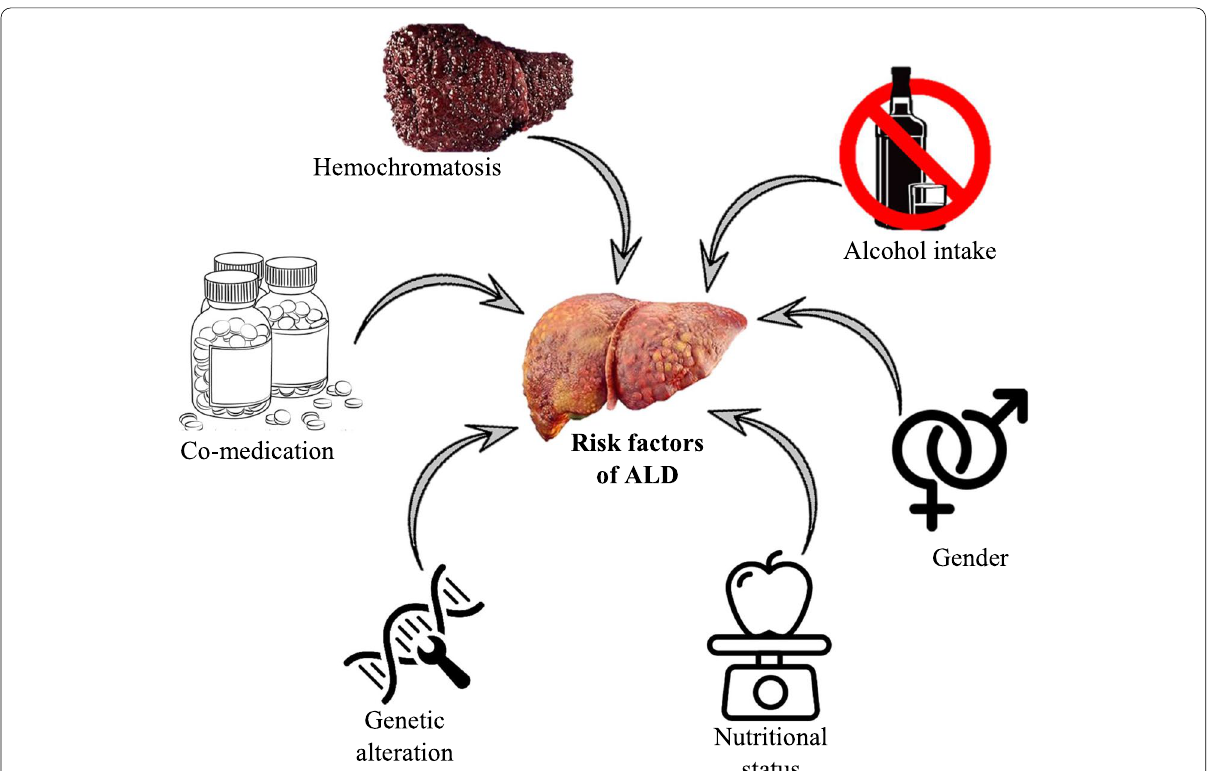
Fig. 1 Various risk factors of alcoholic liver